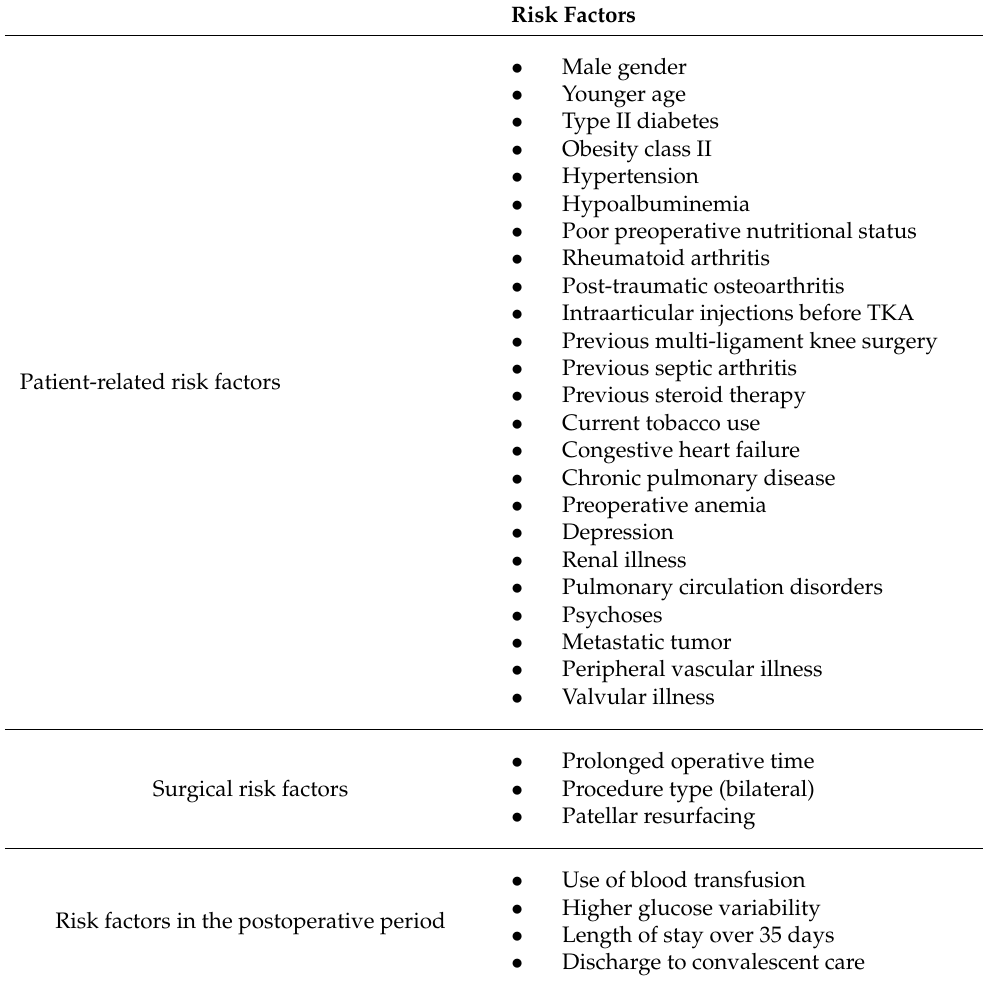
Table 2. Patient-related and surgical risk factors for PJI after primary TKA, as well as risk factors in the postoperative